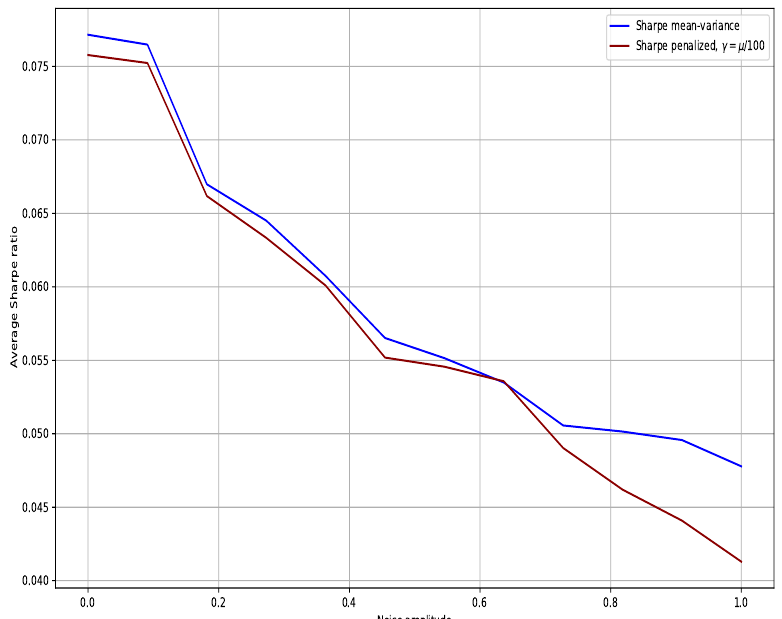
Figure 2. The highest average Sharpe ratio attained by the minimum-variance portfolio is equal to 0.057 for (cid:101) = 0.